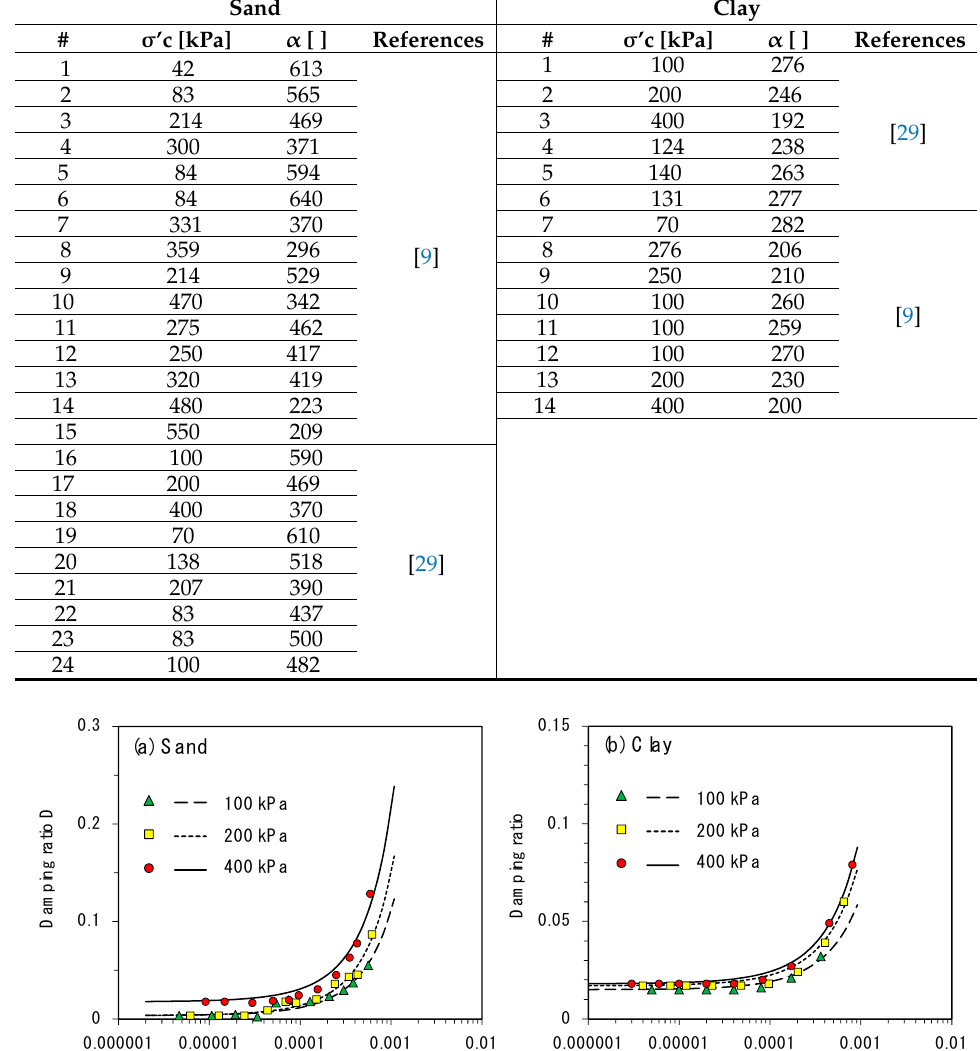
Table 1. Hysteretic nonlinearity parameter determined with the damping ratio data, measured from the resonant column test for sand and clay under the three di ff erent confinement stress levels. Sand Clay # σ ’c [kPa] α [ ]